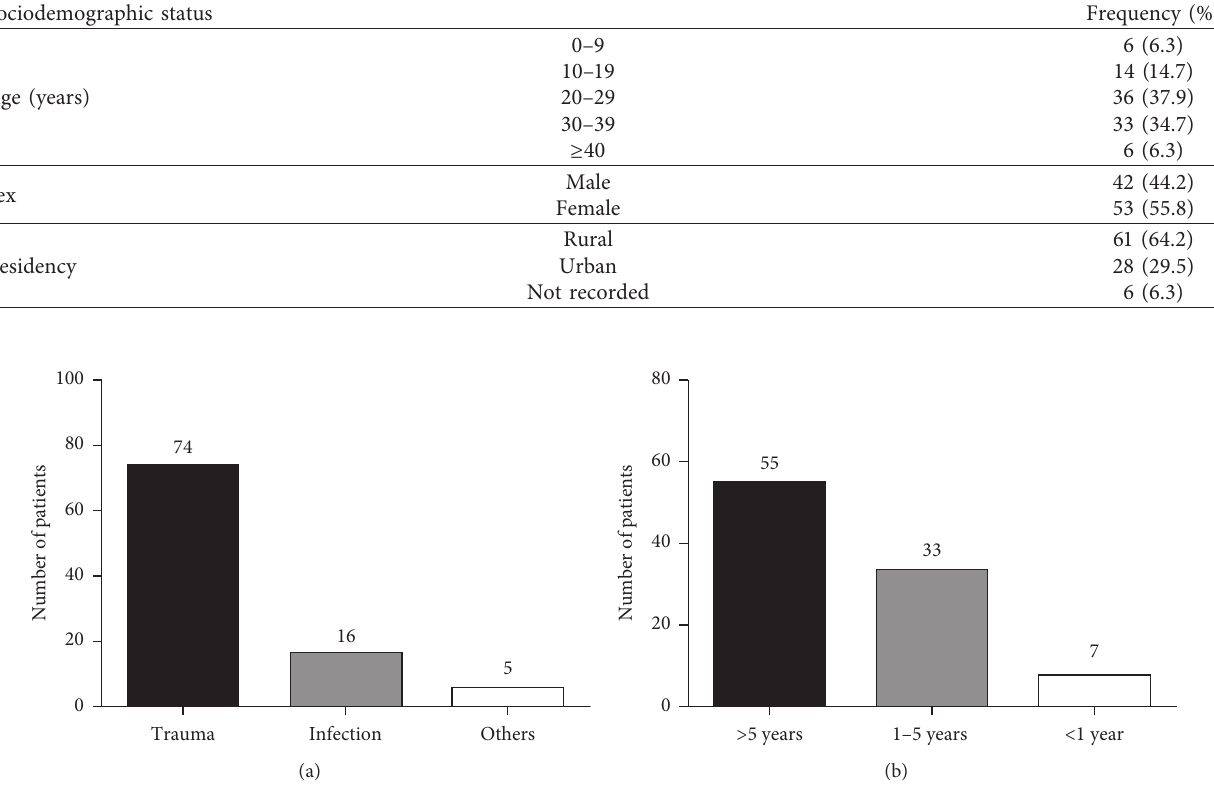
Table 1: Sociodemographic characteristics of the patients.